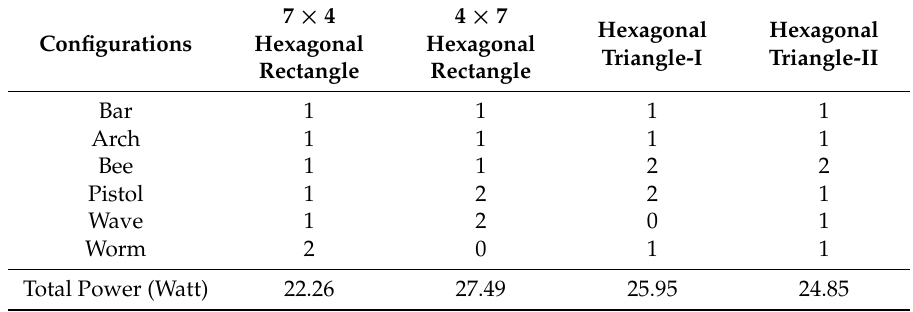
Table 4. Number of forms in four different tiling sets (7 × 4 and 4 × 7 hexagonal rectangle, hexagonal triangle-I, and hexagonal triangle-II) of planar